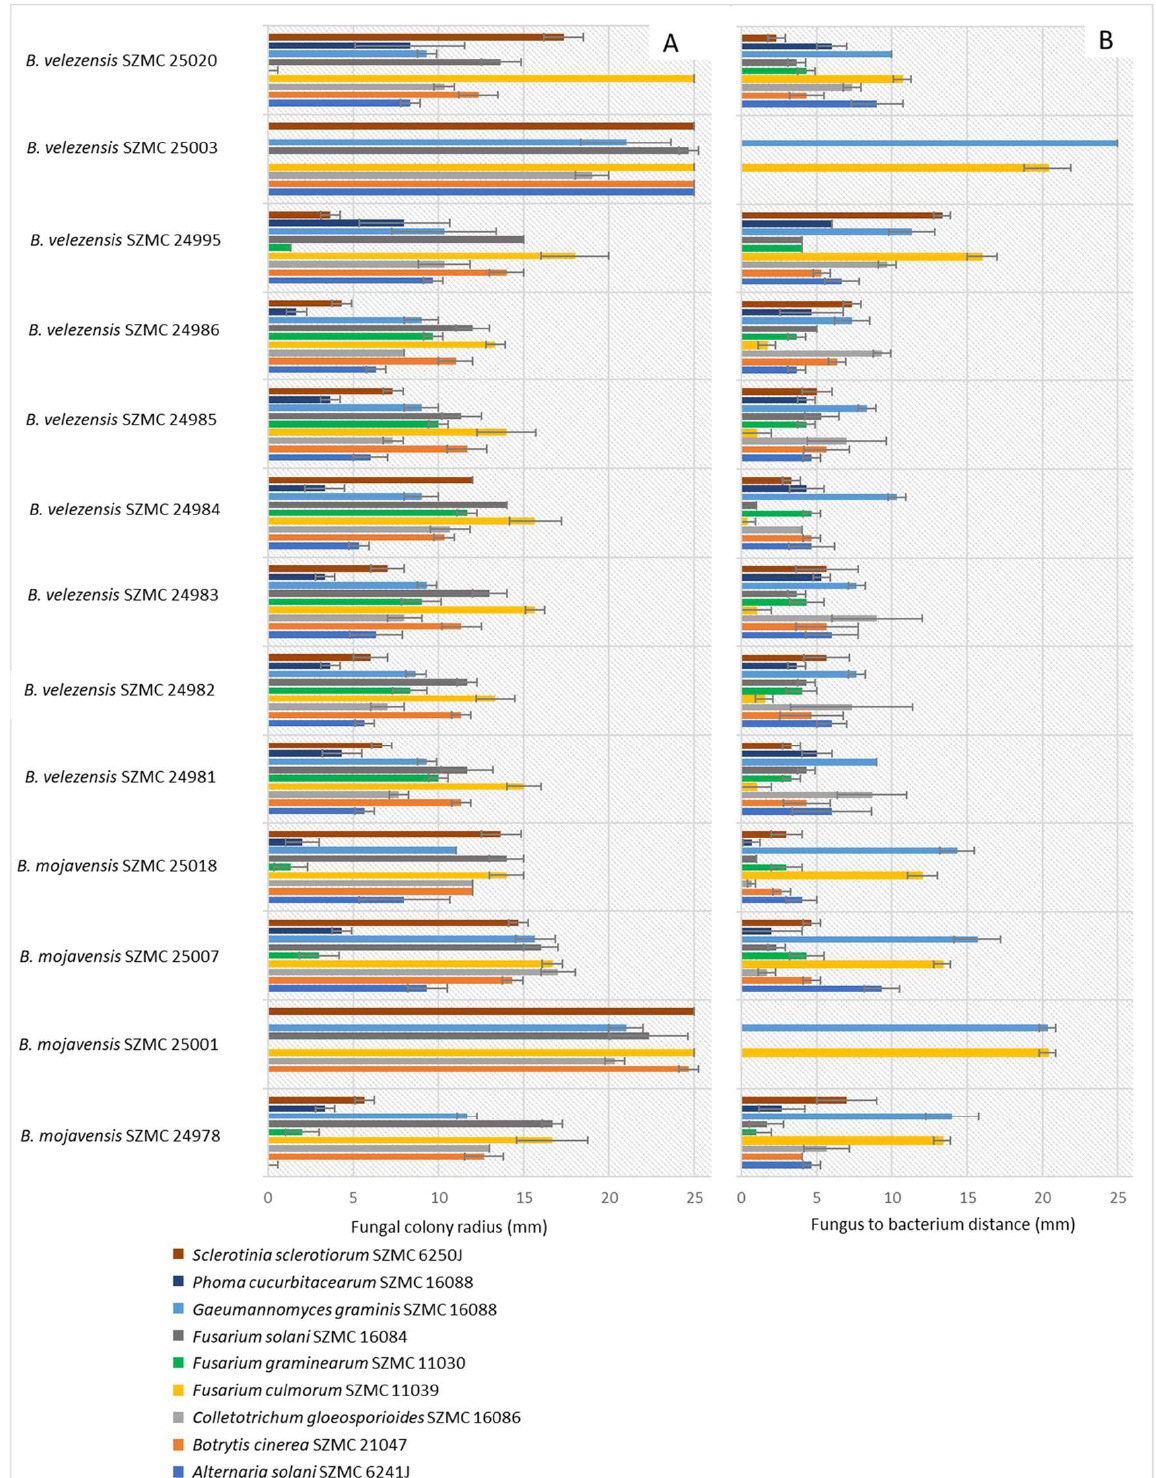
Figure 6. In vitro antagonism of Bacillus strains towards strains of fungal species known as plant pathogens. ( A ). Colony radius of the tested fungi in the presence of biocontrol candidate Bacillus strains. ( B ). Distance between fungal and Bacillus colonies (mean ± SD). Twenty potentially N 2 -fixing bacterial strains were isolated (Table 1). Arthrobacter glo- biformis SZMC 25081 has formed the largest colony on nitrogen source free medium (Table 3). This strain was selected for the soil inoculant.